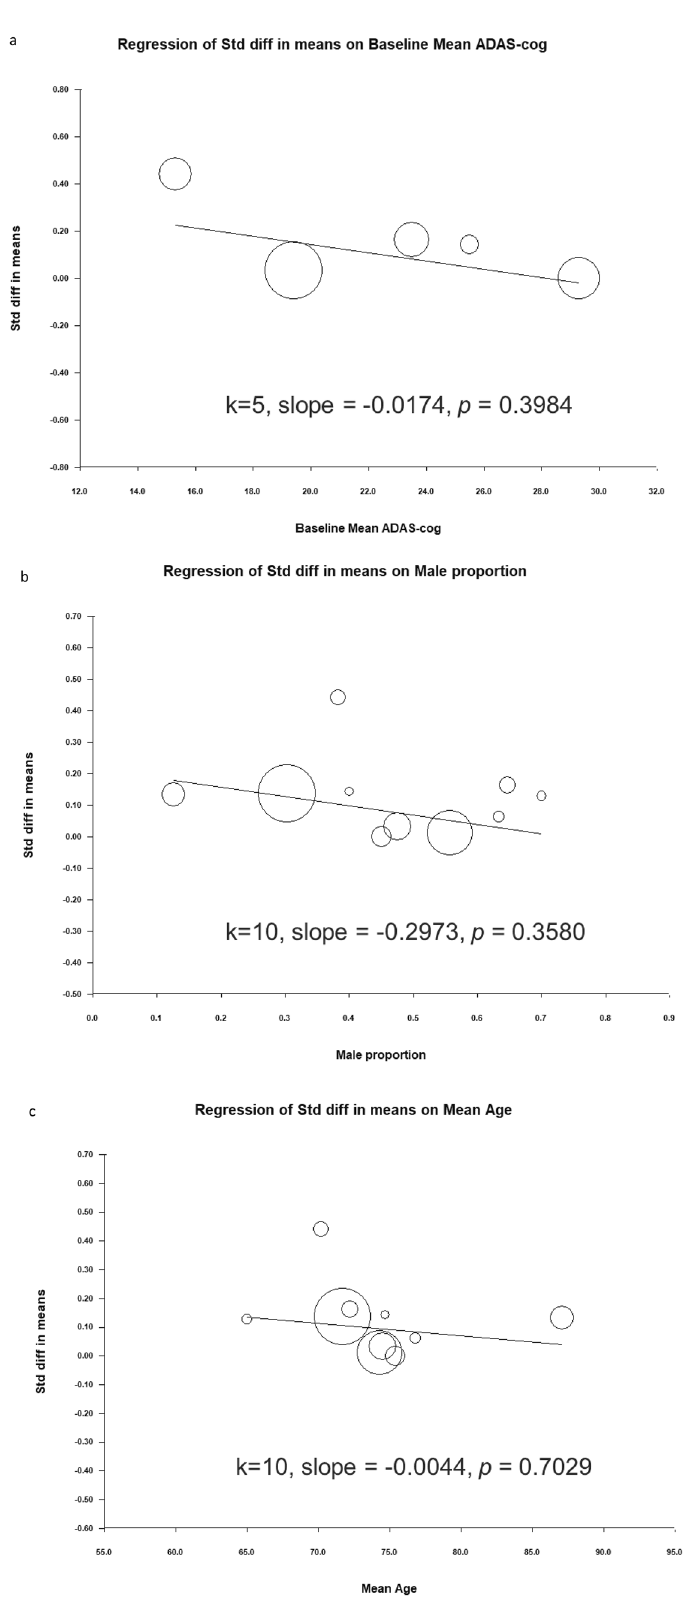
Figure 3. Meta-regression of effects of NMDAR enhancing agents on overall cognitive function in relation to ( a ) baseline mean ADAS-cog total score, ( b ) proportion of men, and ( c ) mean